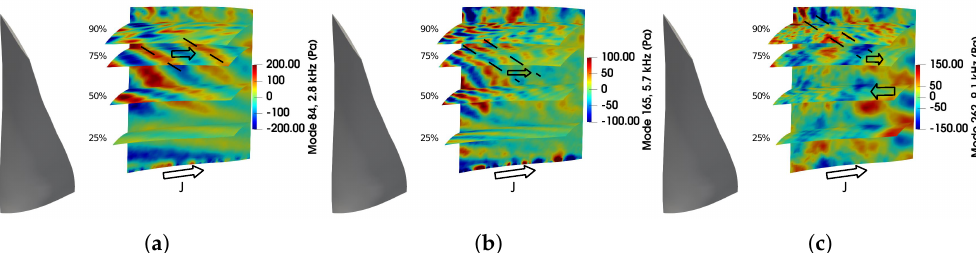
Figure 15. Temporal snapshots of three DMD modes ( t = 0.5 T ) in the downstream volume: ( a ) 2.8 kHz, ( b ) 5.7 kHz, ( c ) 9.1 kHz. The modes correspond to red crosses in Figure 13a. Dashed lines show the orientation of the wave front and the arrows show the axial propagation